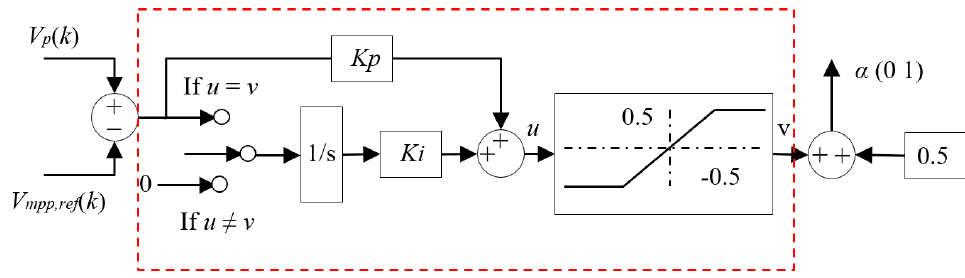
Figure 8. PI-1 controller in detail